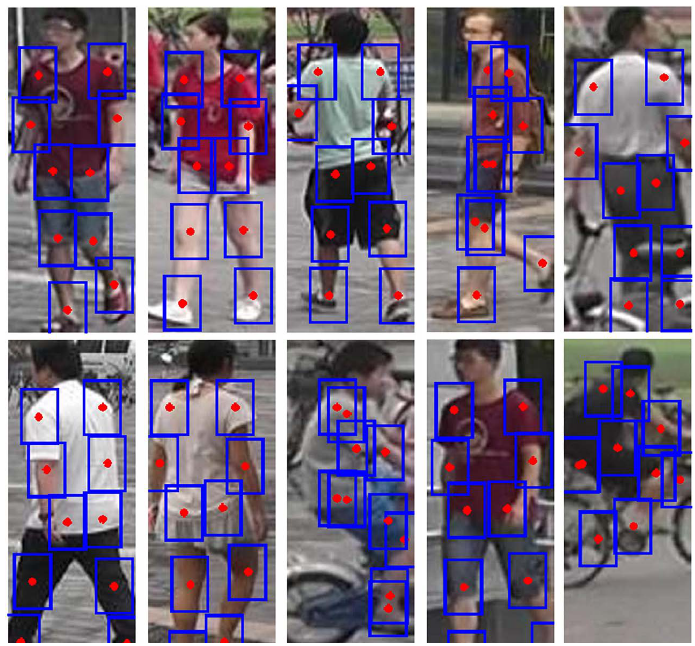
Figure 3. The proposed DJL network with InceptionNet as the base network. The input to DJL includes a pedestrian image and the human body landmarks. We segment ten body part regions according to the landmarks (Section 3.1). A local branch sub-net (Section 3.3) is specially designed in this paper to pool and aggregate multi-level body part representations from the feature maps generated by the global branch base network (Section 3.2). The multi-loss module then optimizes the global and local features jointly.